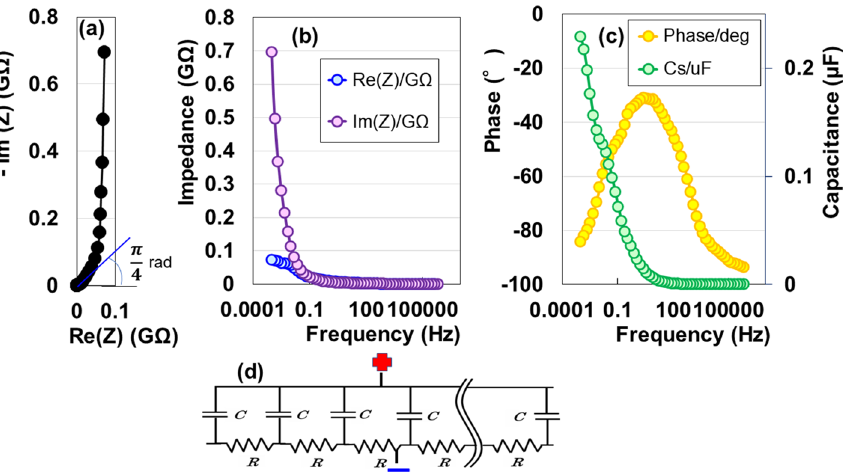
Figure 4. ( a ) Nyquist plot, ( b ) Bode plot, and ( c ) phase and series capacitance as a function of frequency for AAO device. ( d ) Electric distributed constant equipment circuit organized on the AAO